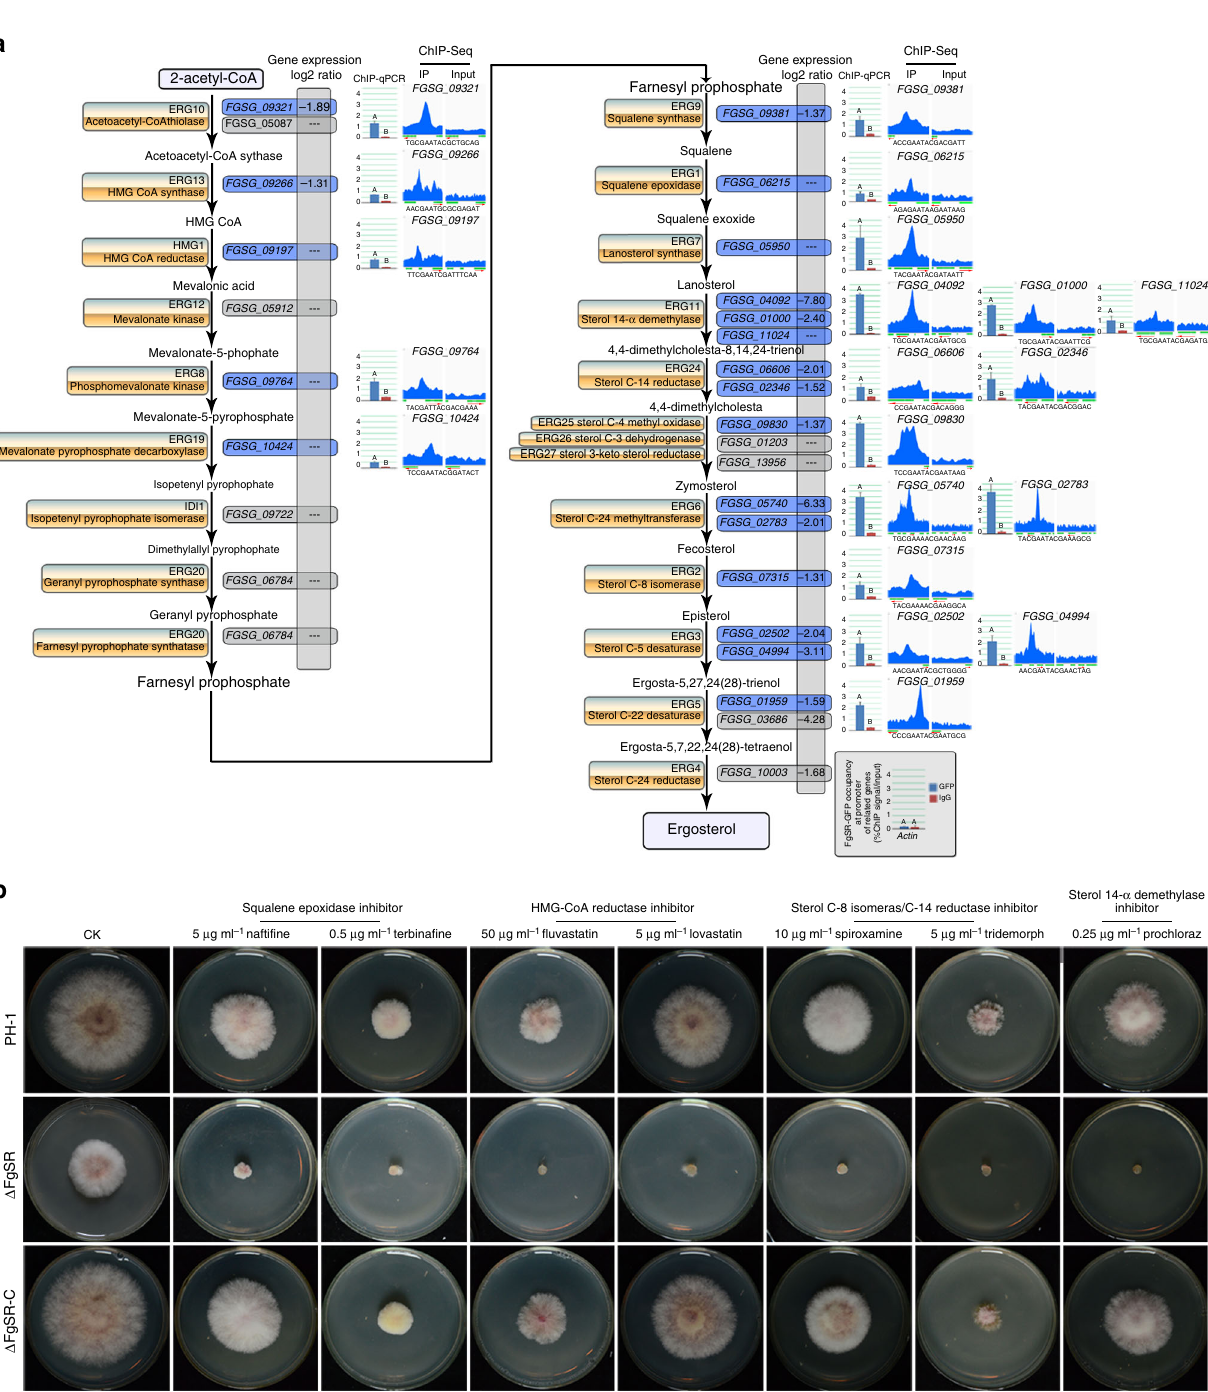
Fig. 6 FgSR is a master regulator of ergosterol biosynthesis in F. graminearum . a ChIP-Seq and -qPCR assays showed that FgSR binds to the promoters of 20 ergosterol biosynthesis genes indicated in blue. RNA-Seq further con fi rmed that 14 out of the above 20 genes were down-regulated in the Δ FgSR mutant. FgACTIN was use as a negative control in the ChIP-qPCR assay. ChIP- and input-DNA samples were quanti fi ed by quantitative PCR assays with the primer pair A2 indicated in Fig. 2b, and rabbit IgG was used as a control. The red arrow indicates the gene direction from 5 ′ to 3 ′ . The green bar represents the gene promoter region, which is covered during ChIP-Sequencing. “ black dashed line ” indicates no change in gene transcription determined by the RNA-Seq assay (Supplementary data 3). The sequences below the kurtosis graphs represent the cis -elements within the promoters of the 20 ergosterol pathway genes identi fi ed by MEME analysis. Values on the bars followed by the same letter are not signi fi cantly different at P = 0.01. b FgSR regulates F. graminearum sensitivity to sterol biosynthesis inhibitors (SBIs) targeted to different biosynthetic enzymes. A 5-mm mycelial plug of each strain was inoculated on PDA supplemented with 5 μ g ml – 1 nafti fi ne, 0.5 μ g ml – 1 terbina fi ne, 5 μ g ml – 1 fl uvastatin, 5 μ g ml – 1 lovastatin, 10 μ g ml – 1 spiroxamine, 5 μ g ml – 1 tridemorph, or 0.25 μ g ml – 1 prochloraz and then incubated at 25 °C for 3 days. As a control, each strain was cultured on PDA without supplementation